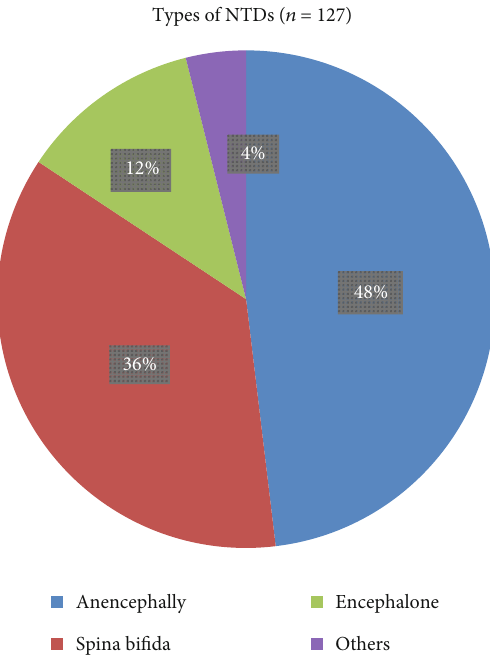
Figure 1: Types of NTDs among the cases of the neonates born in the hospitals, Amhara Region, Ethiopia,